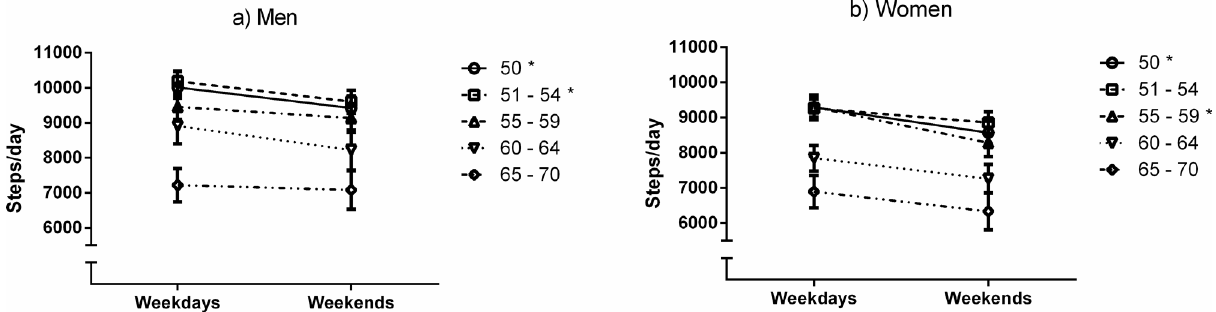
Figure 1. Differences in means and standard deviations of steps/day values on weekdays and weekend days in men (a) and women (b) of different age groups (*p <